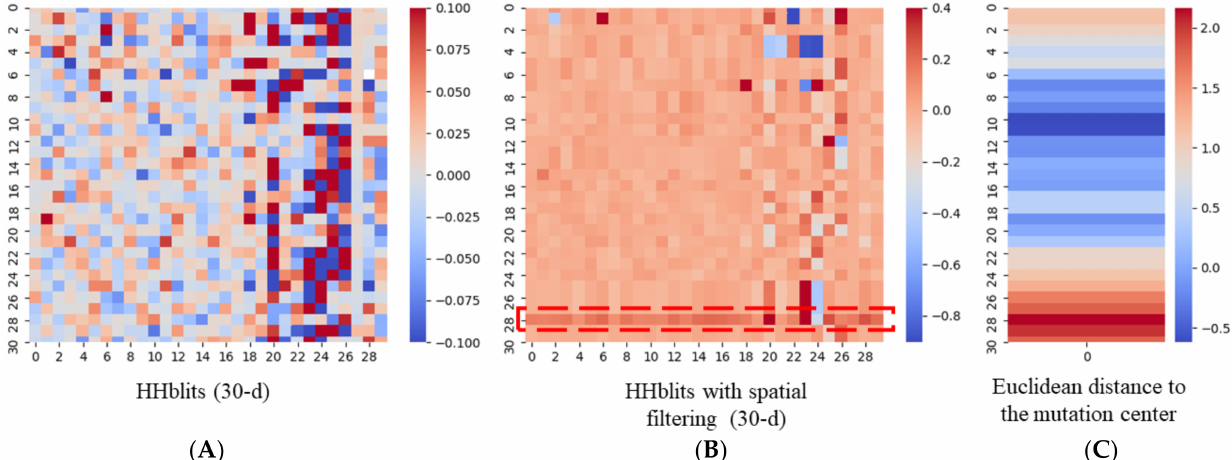
Figure 4. The visualization of the change rate of HHblits and Euclidean distance to the mutated residue before and after mutation. Taking the mutant residue as the center, we simulated the operation of the sliding window and clipped the sequence into a fragment with a length of 31 residues. The 16th position represents the mutant residue. ( A ) Heatmap of the change rate of classical HHblits profiles. ( B ) Heatmap of the change rate of HHblits with spatial filtering (radius = 7 Å). The highlighted area represents the 29th residue (Y) of the current window. ( C ) Heatmap of the change rate of the Euclidean distance to the mutation